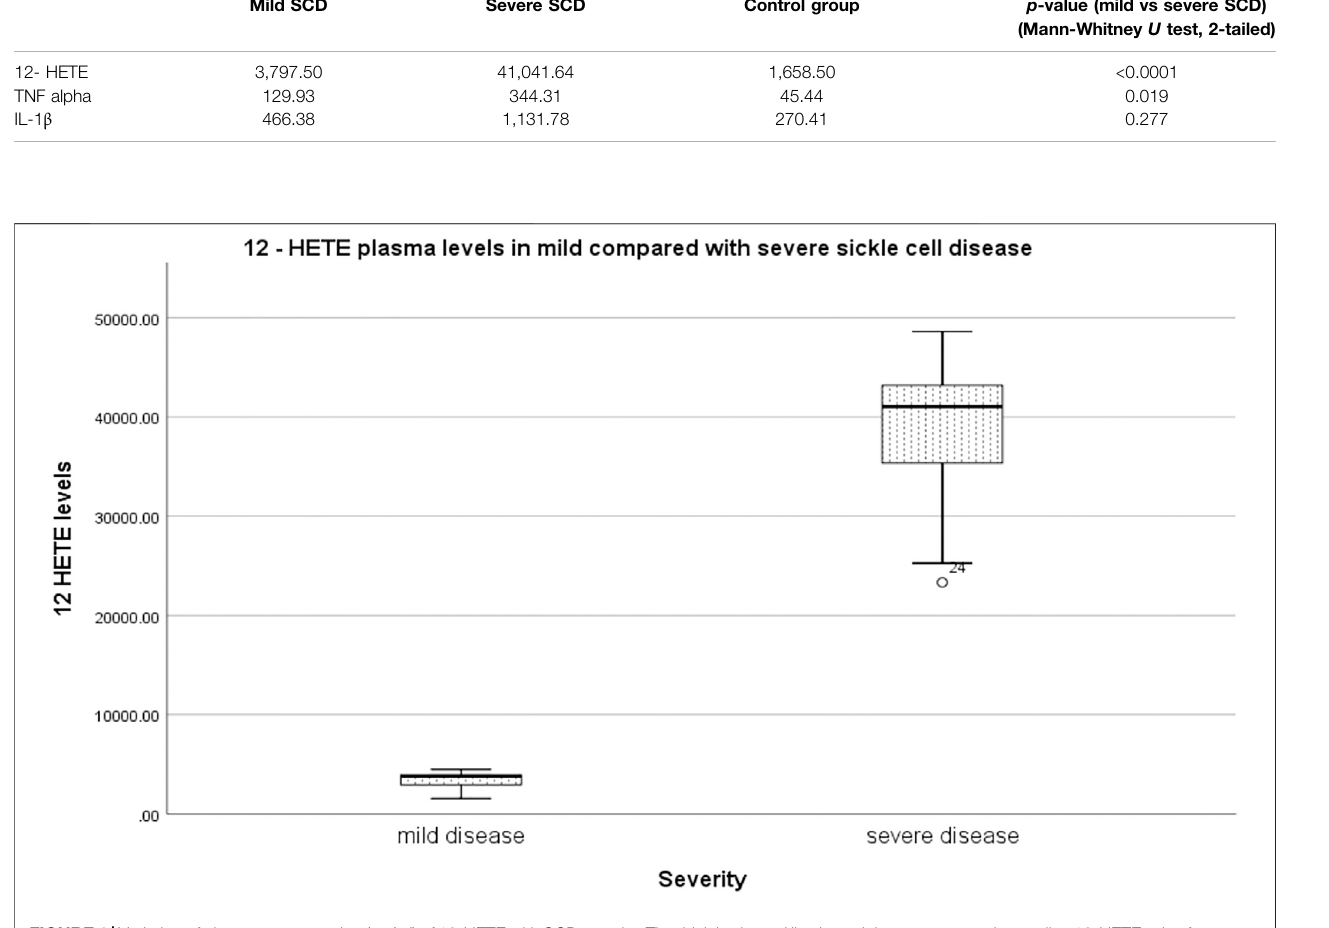
Frontiers in Genome Editing |